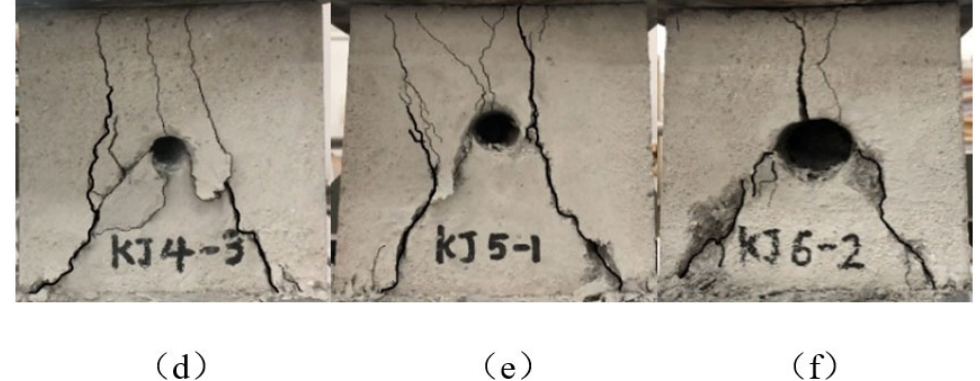
Figure 5. ( a ) is the failure diagram of the sample with a borehole diameter of 6 mm, ( b ) is the failure diagram of the sample with a borehole diameter of 10 mm, ( c ) is the failure diagram of the sample with a borehole diameter of 15 mm, ( d ) is the failure diagram of the sample with a borehole diameter of 20 mm, ( e ) is the failure diagram of the sample with a borehole diameter of 25 mm, and ( f ) is the failure diagram of the sample with a borehole diameter of 40 mm.